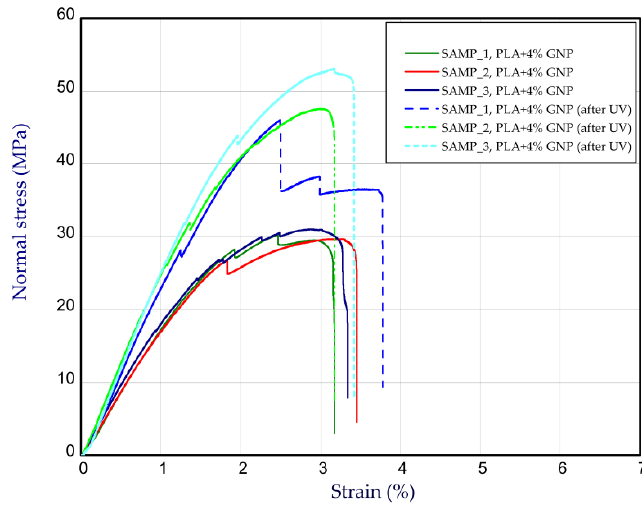
Figure 5. The curves of tensile tests of PLA ( a ) at wt. 2% and ( b ) at wt. 4% GNP. Table 1. Characteristic parameters obtained in tensile tests for all samples.